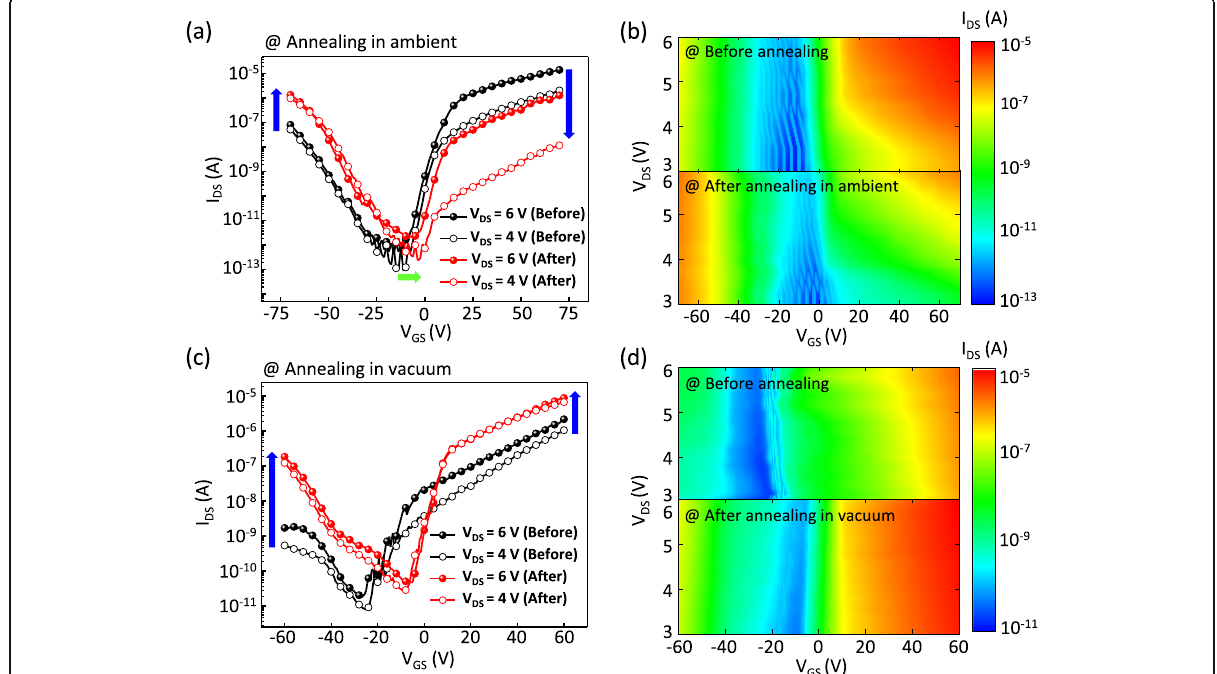
Fig. 2 a , c I DS - V GS curves on the semilogarithmic scale of a WSe 2 FET before annealing and after annealing at 200 °C for 1 h. b , d Contour plots of I DS as a function of V GS and V DS before annealing (upper panel) and after annealing at 200 °C for 1 h (lower